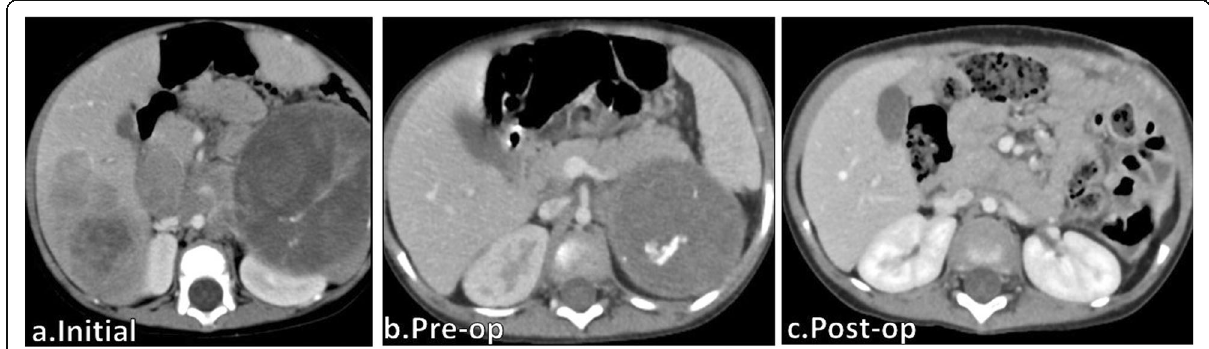
Fig. 4 A 45-week-old male. a Initial CT axial cut revealed left suprarenal mass lesion with enlarged abdominal lymph nodes encasing the aorta, as well as liver metastasis. b Pre-operative CT axial cut showing regressive course regarding the size of the left suprarenal mass and abdominal lymph node with disappearance of all IDRFs. c Post-operative CT axial cuts revealed clear operative bed with no evidence of residual mass